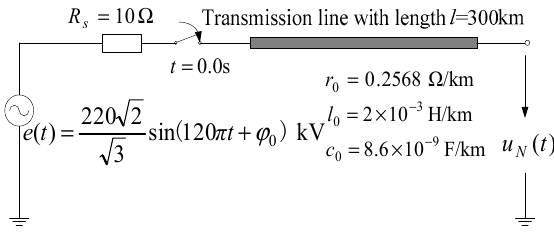
Figure 6. Schematic diagram of a single-phase high-voltage overhead transmission line without load being switched-in suddenly.